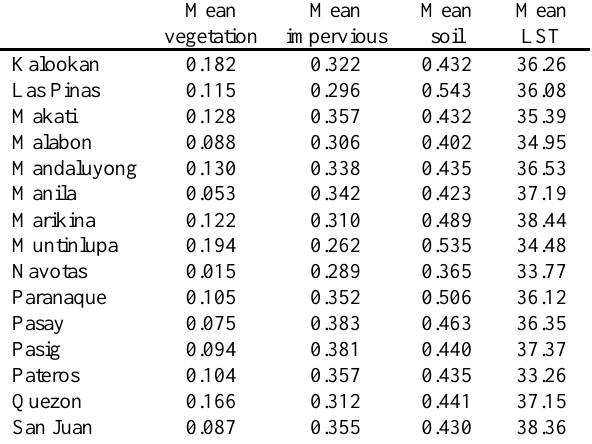
Table 2. Mean values of vegetation, impervious surface, soil and LST calculated over the cities of Metro